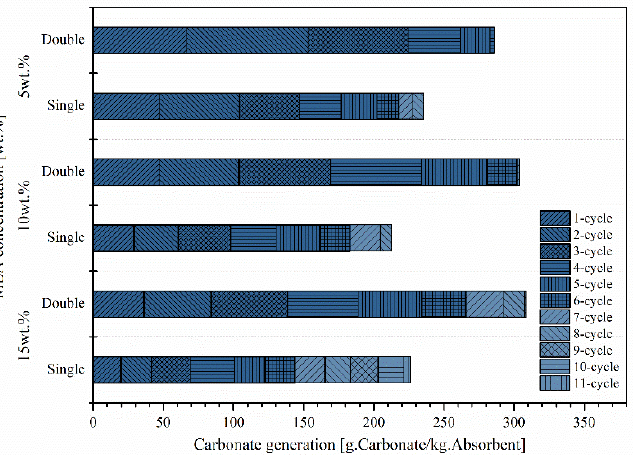
Figure 3. Difference of carbonate generation between precipitation in single and double steps in multicycle IAM. multicycle